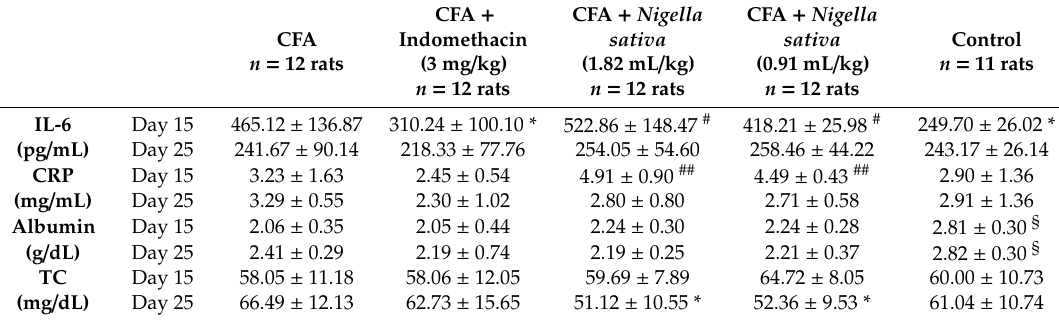
Table 2. E ff ect of Nigella sativa oil on interleukin-6 (IL-6), C-reactive protein (CRP), albumin and total cholesterol (TC) levels in plasma of CFA-induced arthritic rats. CFA + CFA + Nigella CFA + sativa CFA Indomethacin n = 12 rats (3 mg / kg) (1.82 mL / kg) n = 12 rats